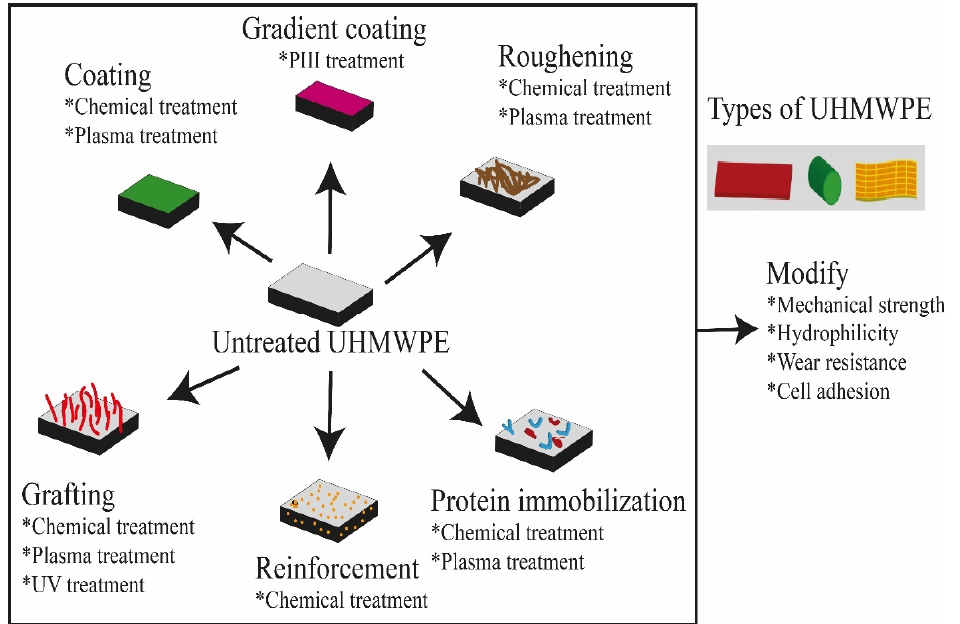
Figure 1. Contrasting approaches for surface functionalization of UHMWPE. Table 1. The influence on surface properties of UHMWPE after surface treatment.